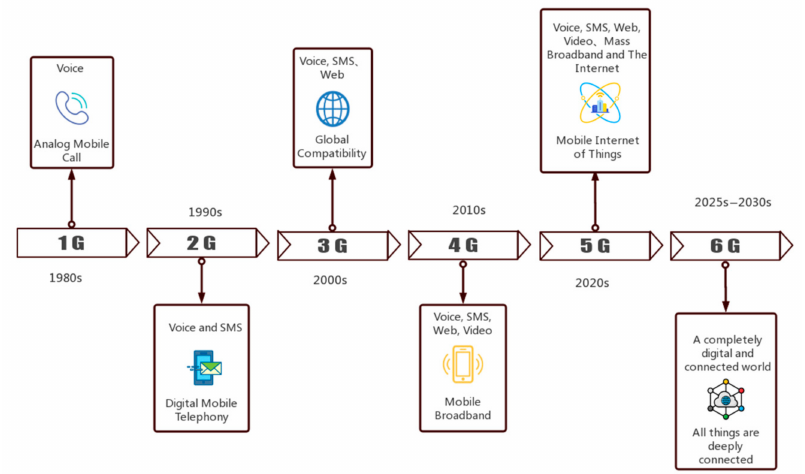
Figure 7. Development trend from 1G to